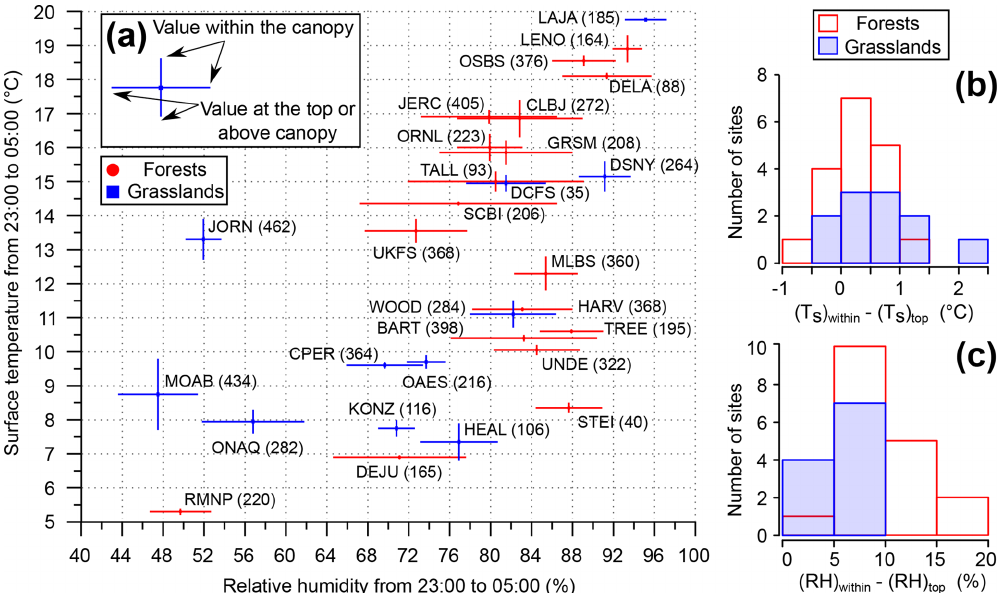
Figure 2. (a) T s versus RH from 23:00 to 05:00 the next day over the growing season for each site (number of nights is indicated in parenthesis). Four mean values have been calculated per site, two from the sensors within canopy and two from the sensors at the top of canopy. (b, c) Histograms of the difference in T s (and RH) between that within canopy and that at the top of the canopy. SERC is missing because of a sensor failure above